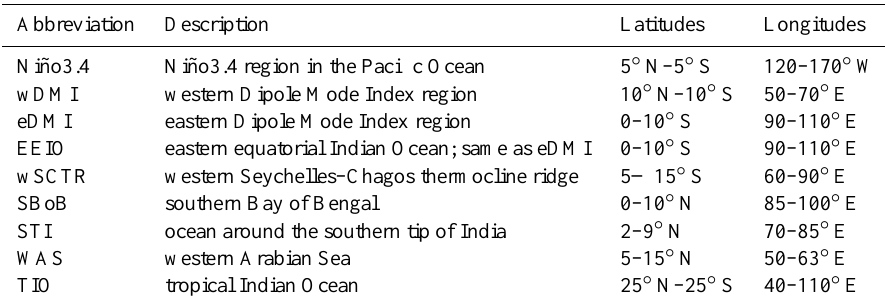
Fig. 1. Seasonal evolution of average S Chl patterns from SeaWiFS satellite estimates (left panels) and model outputs (right panels). Seasons are represented as December–February (DJF), March–May (MAM), June–August (JJA) and September–November (SON). The seasonal cycle was calculated over the 1998–2009 period for observations and 1990–2001 for the model (see Sect. 3 for details). Table 1. Description and coordinate boundaries of the areas used in the calculation of climate indices and of regions investigated in greater detail. These regions of interest are also indicated in Figs. 3 and